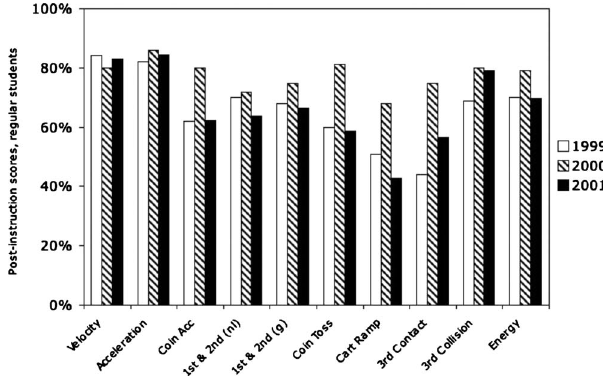
FIG. 3. Postinstruction scores for Regular students, exposed to ILD methods of